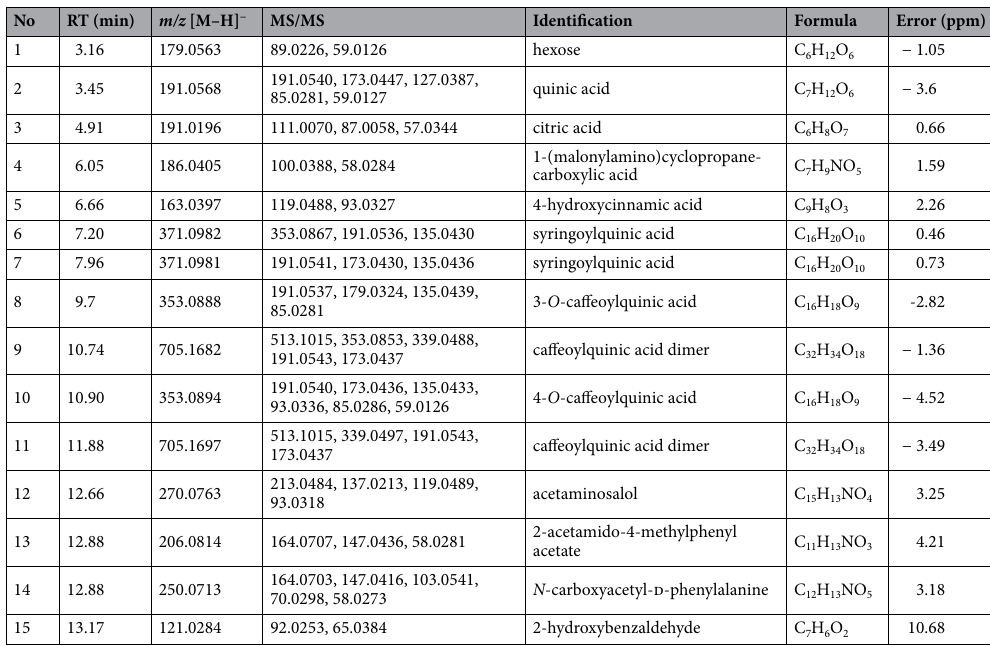
Table 1. Phytochemicals in F. dubia sap extract identified using LC–ESI–MS/QTOF method in the negative ionization